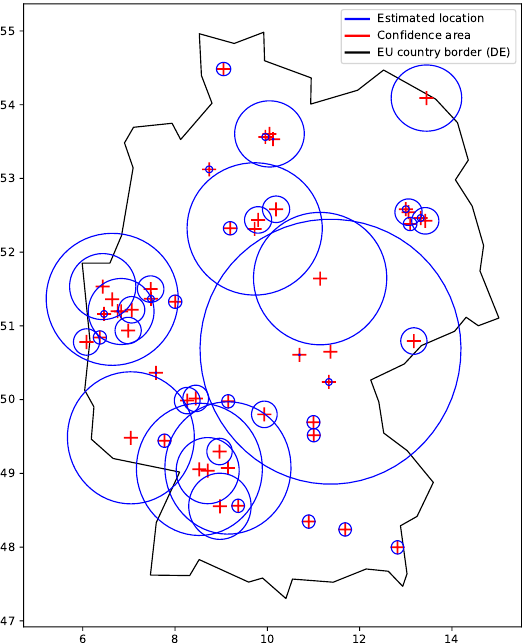
Figure 5. Confidence area and locations obtained for sample IP addresses. Large areas indicate uncertain locations. Small areas are used for trusted